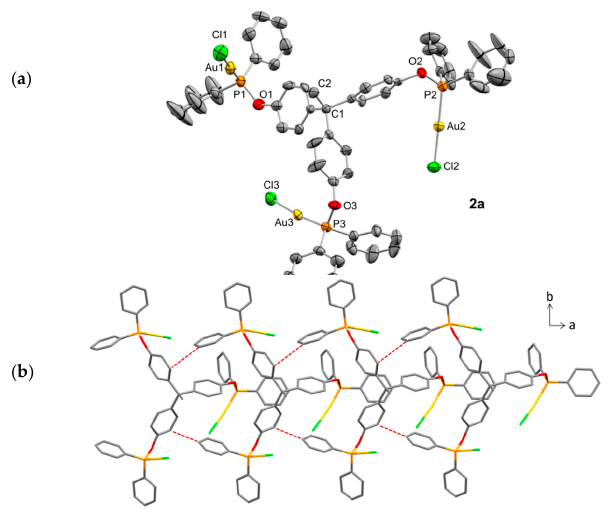
Figure 3. ( a ) ORTEP view of the solid structure of compound 2a with thermal ellipsoids set at 50% probability. Hydrogen atoms have been excluded for the sake of clarity. Selected bond distances (Å) and angles (°): Au1 − P1, 2.214(3); Au1 − Cl1, 2.279(4); Au2 − P2, 2.228(3); Au2 − Cl2, 2.290(3); Au3 − P3,